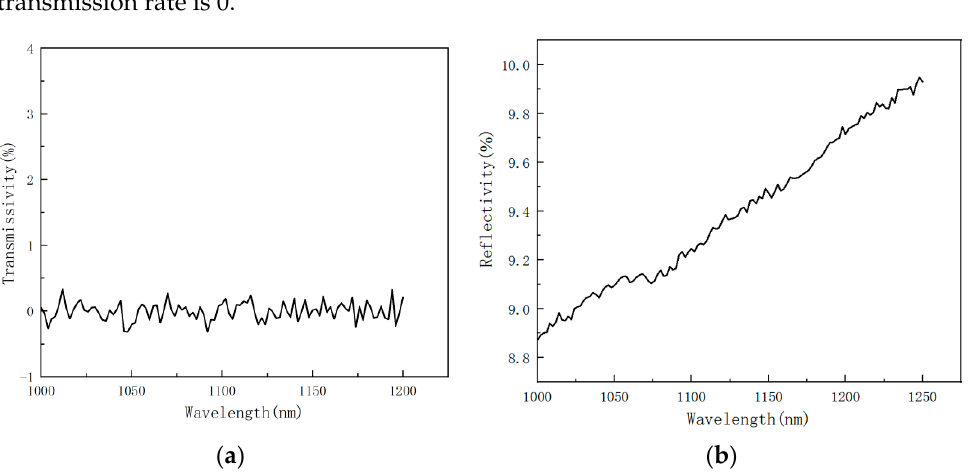
Figure 4. Variation curves of transmittance and reflectance of CFRP laminates as a function of incident wavelength. ( a ) transmission rate; ( b ) reflectance rate.